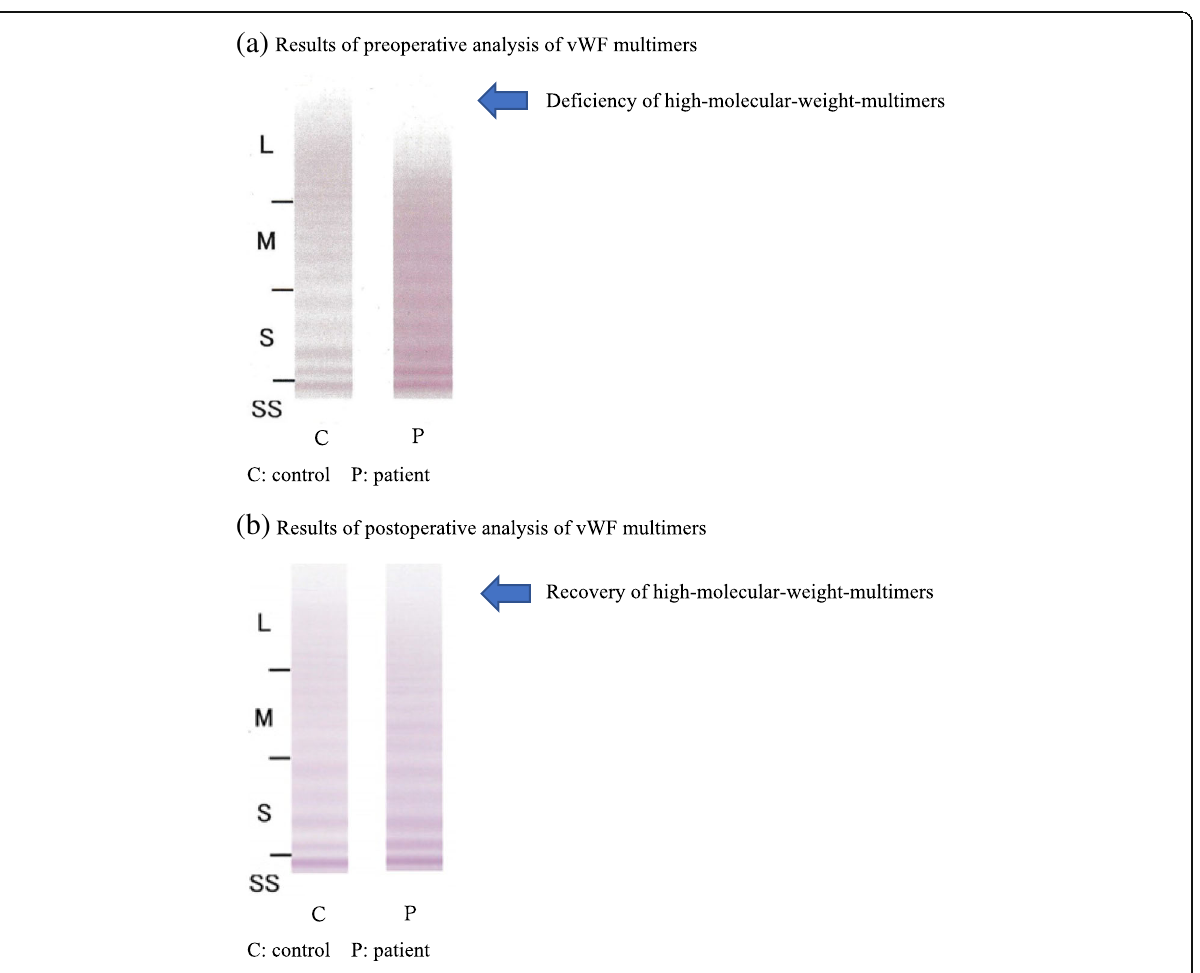
Fig. 1 a Results of preoperative analysis of vWF multimers. b Results of postoperative analysis of vWF